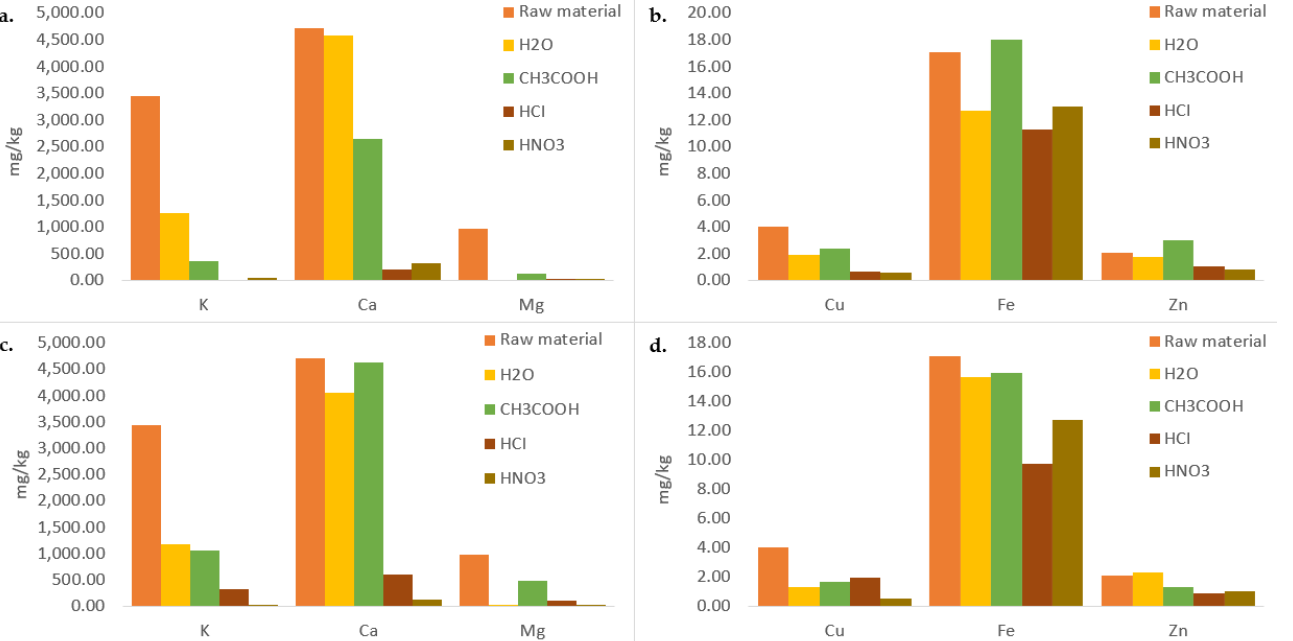
Figure 4. Atomic spectrometry analysis of: ( a ) macro elements in untreated and treated soybean II within 30 min ( b ) micro elements in untreated and treated soybean II within 30 min ( c ) macro elements in untreated and treated soybean II within 240 min ( d ) micro elements in untreated and treated soybean II within 240